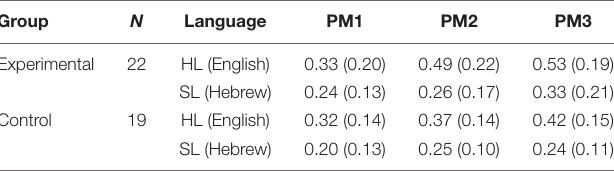
TABLE 4 | Mean scores for vocabulary breadth in each progress monitoring session in each language (reported as